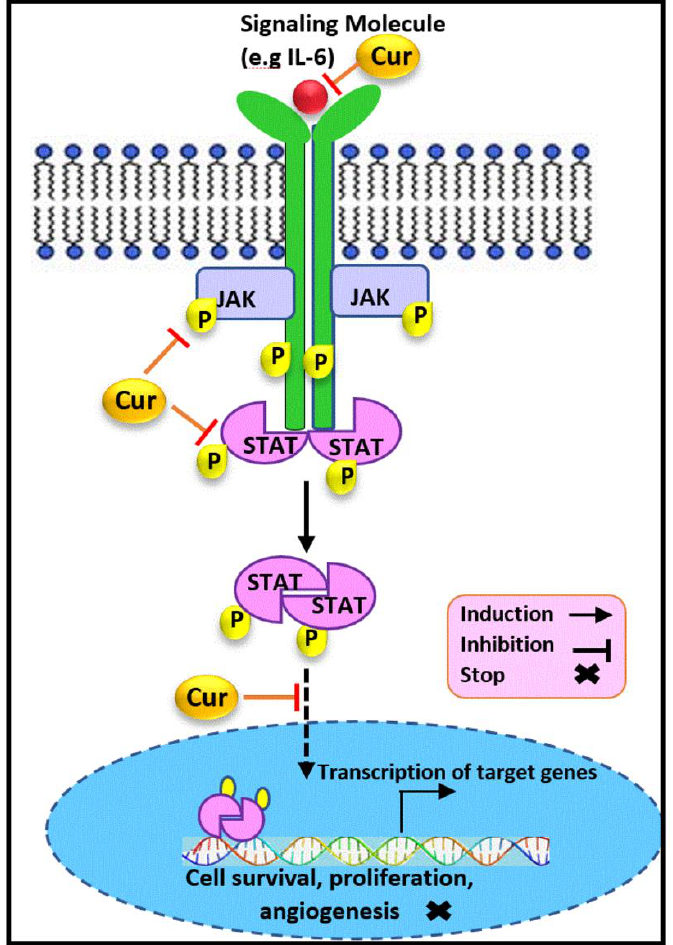
Figure 2. The modulatory effect of curcumin on the JAK/STAT3 pathway. Curcumin inhibits the JAK/STAT3 signaling pathway through the regulation of its key components. Curcumin downregulates STAT, JAK, and IL-6 expression and inhibits STAT translocation into the nucleus, which results in the suppression of cell proliferation, invasion, and metastasis in hormone receptor negative breast cancer. Cur: curcumin, JAK: janus kinase, STAT: signal transducer and activator of transcription, IL-6: interleukin-6.